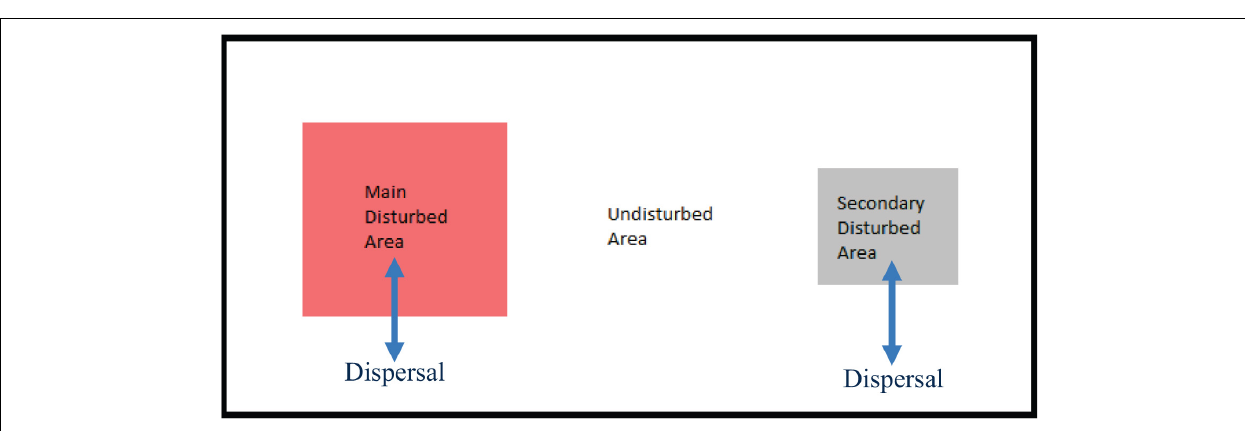
FIGURE 3 | Diagram of undisturbed and disturbed areas. Schematic of the stylized landscape with undisturbed and the main and secondary disturbed areas in which animal dispersal can occur between undisturbed and disturbed